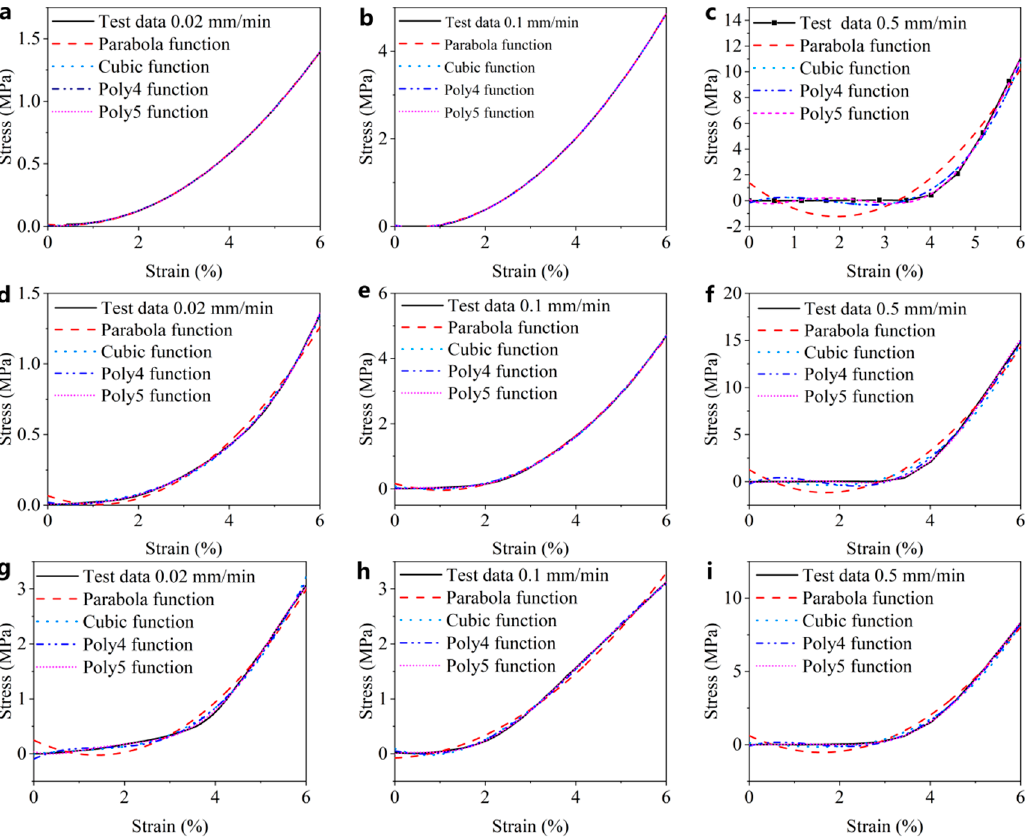
Figure 12. The fitting curves of four polynomial hyperelastic models. ( a – c ) Fitting curve of sample 1 at different rates; ( d – f ) fitting curve of sample 2 at different rates; ( g – i ) fitting curve of sample 3 at different rates.